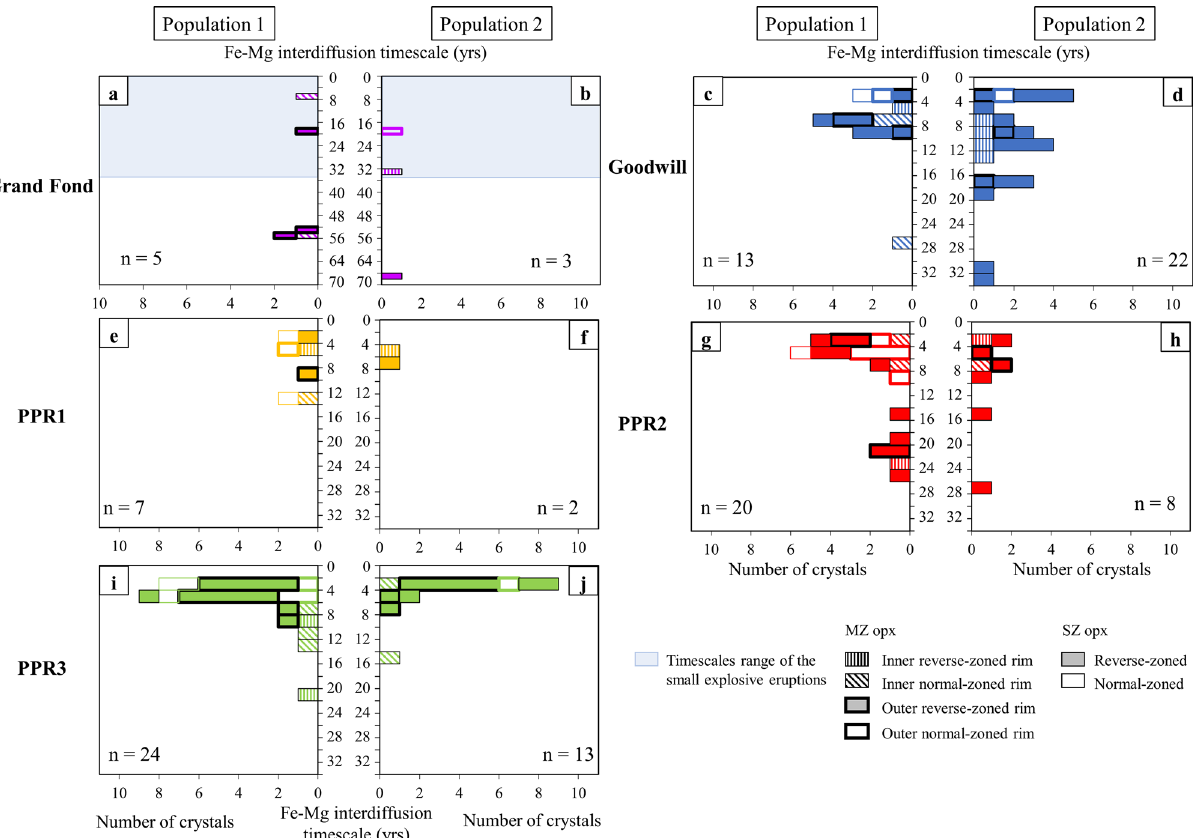
Figure 5. Frequency histograms of Fe–Mg interdiffusion timescales modelled in opx at 850 ± 25 °C for Grand Fond ( a , b ) and 890 ± 9 °C for core-rim and inner-outer rim boundaries of single-zoned (SZ) and multiple-zoned (MZ) opx of the two opx populations as in Figs. 3 and 4, of Goodwill ( c , d ), PPR1 ( e , f ), PPR2 ( g , h ) and PPR3 ( i , j ). The type of zonation is specified (reverse-zoned or normal-zoned). The timescales are presented as